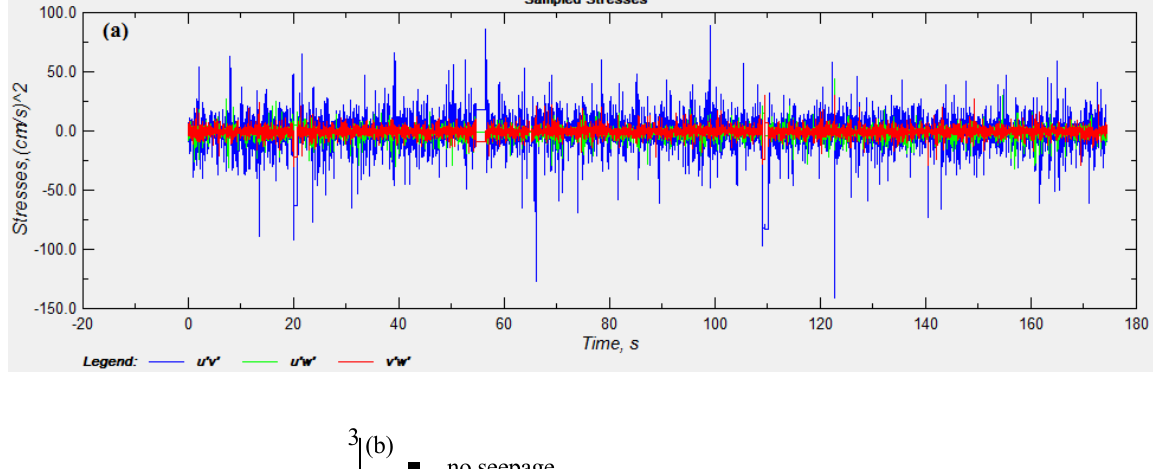
Figure 5. Vertical profiles of ( a ) time-averaged streamwise velocity ( u ) and ( b ) vertical velocity ( w ) for all experiments in this study.